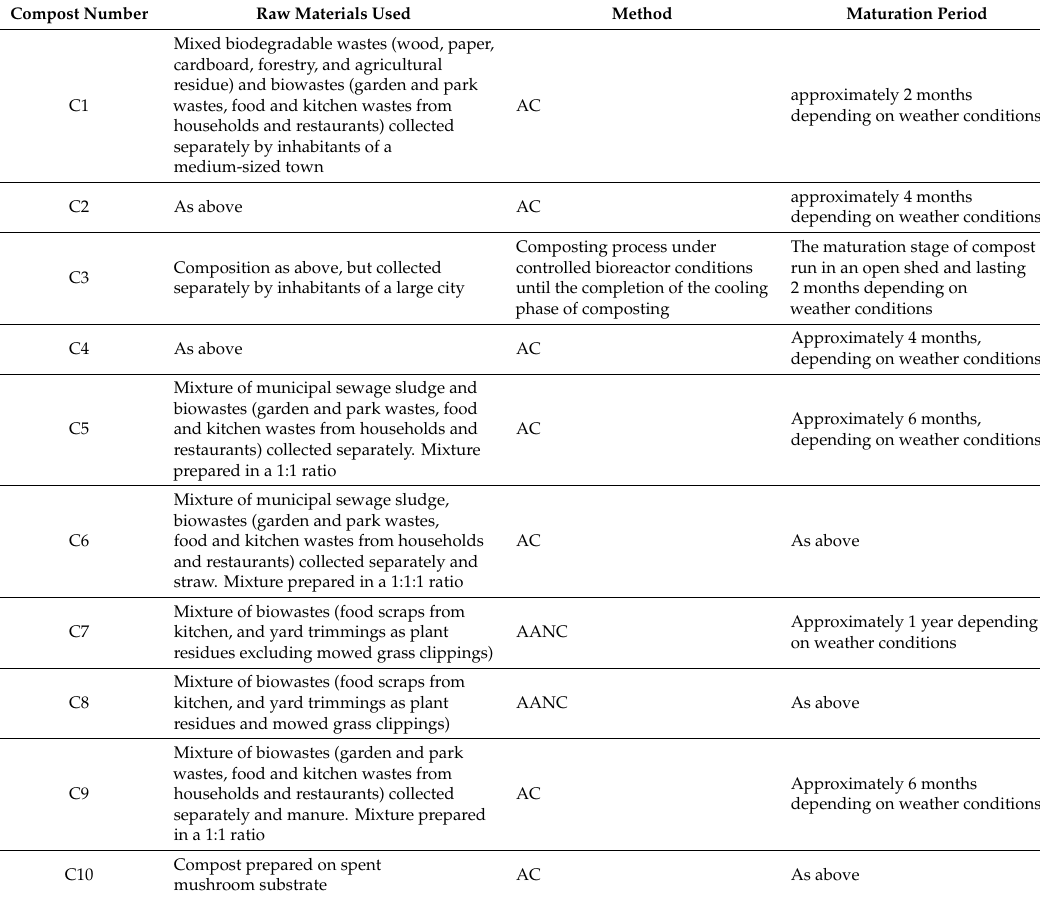
Table 1. Raw materials and methods used for individual composts. AC: aerobic composting, AANC: aerobic–anaerobic